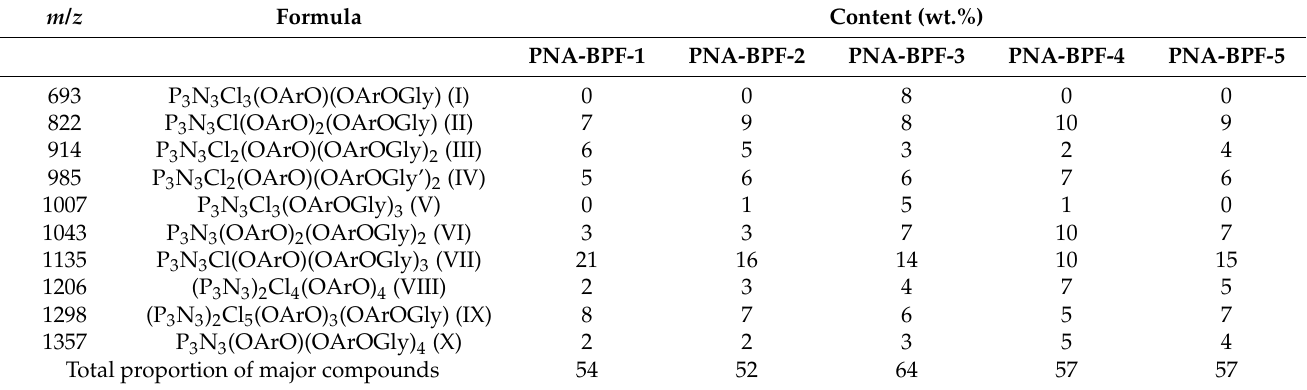
Table 3. The main compounds formed during the synthesis of PNA-BPF and PNA-BPF-S, the share of which is more than 4% in at least one of the